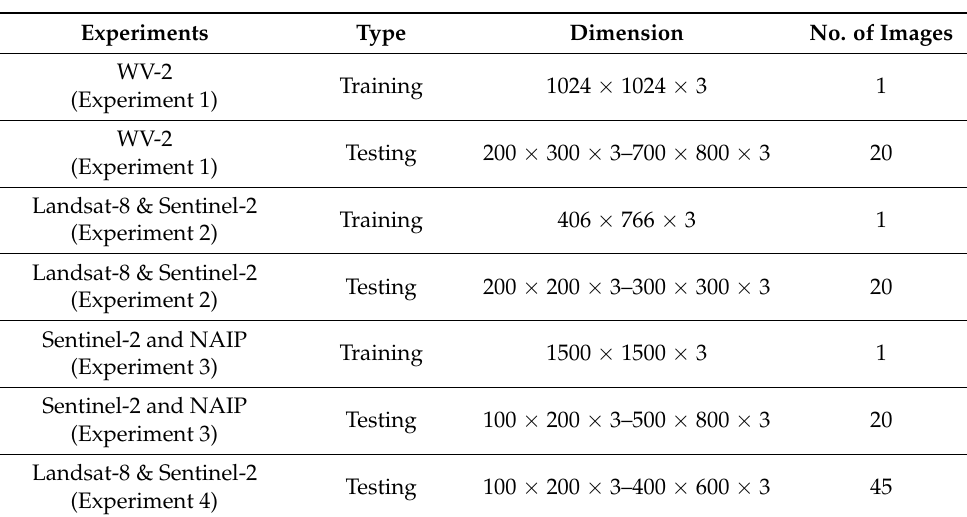
Table 2. Details of training and testing